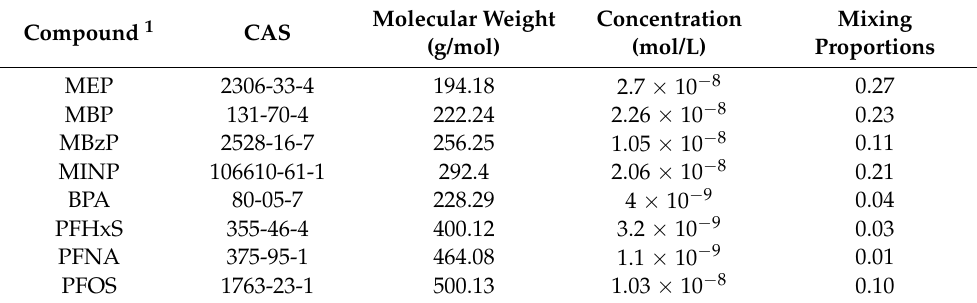
Table 1. MIX N concentrations based on SELMA biomonitoring data, where neurodevelopmental adversity was observed [3]. Compound